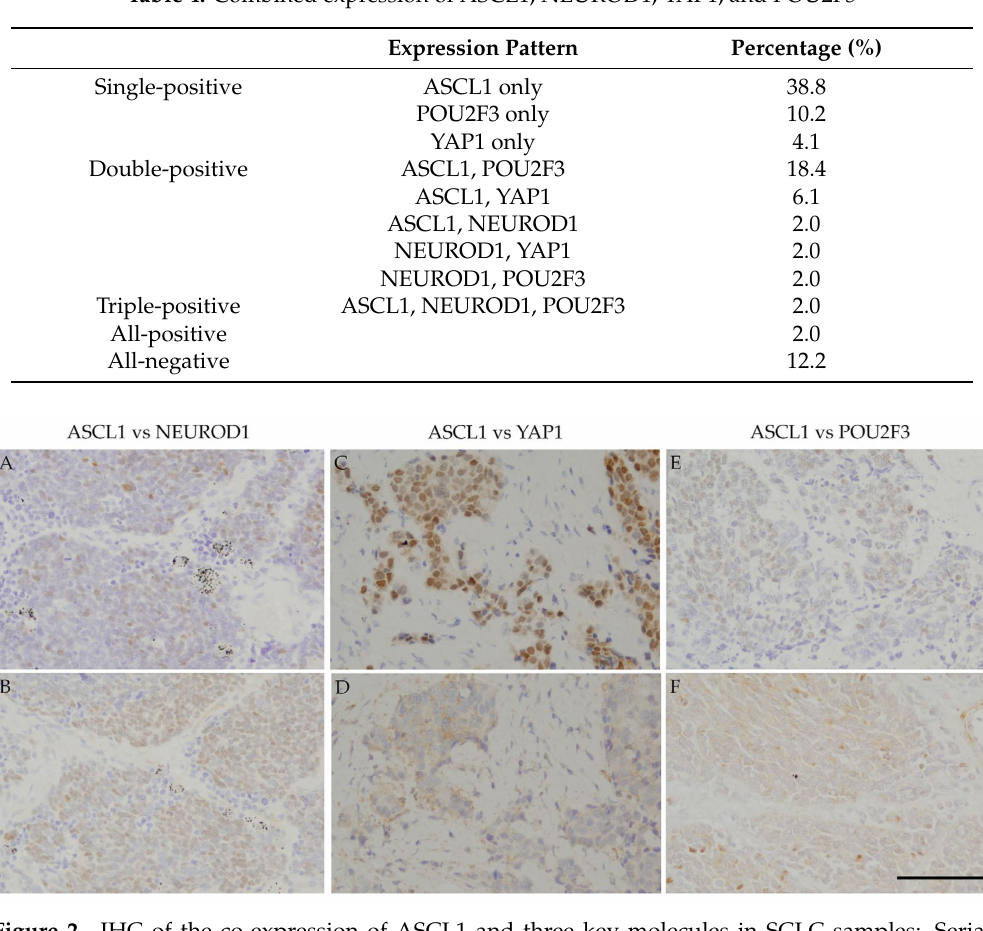
Figure 2. IHC of the co-expression of ASCL1 and three key molecules in SCLC samples: Serial section immunostaining for ASCL1 (A) and NEUROD1 (B). SCLC cell nuclei were positive for ASCL1 ( A ) and NEUROD1 ( B ). Serial section immunostaining for ASCL1 ( C ) and YAP1 ( D ). SCLC cell nuclei were positive for ASCL1 ( C ), and the cytoplasm was positive for YAP1 ( D ). SCLC cell nuclei were positive for ASCL1 ( E ), and the cytoplasm was positive for POU2F3 ( F ). Scale bar = 100 µ